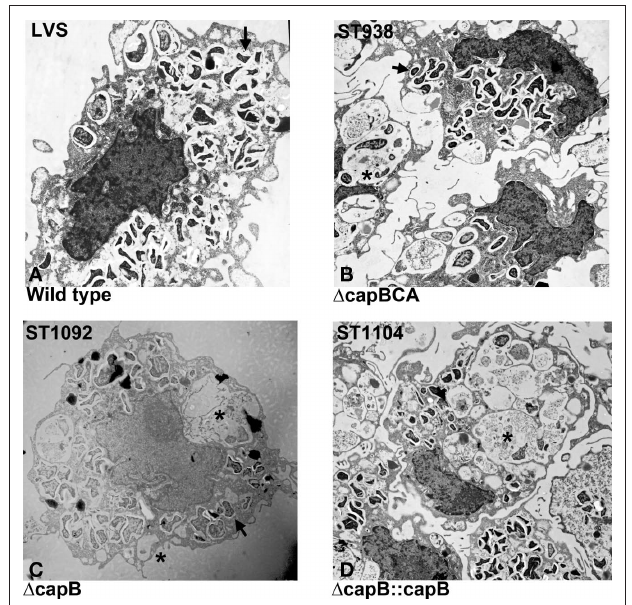
Figure 6 | Sub-cellular ultra-structures of u937 macrophages infected by LVS capBCA mutants. Electron micrographs of human macrophages inoculated with F. tularensis LVS (A) , ∆ capBCA (ST938) (B) , ∆ capB (ST1092) (C) , or complemented ∆ capB (ST1104) (D) . Indicated are the intact bacteria (arrow heads) and vacuoles containing degraded bacteria